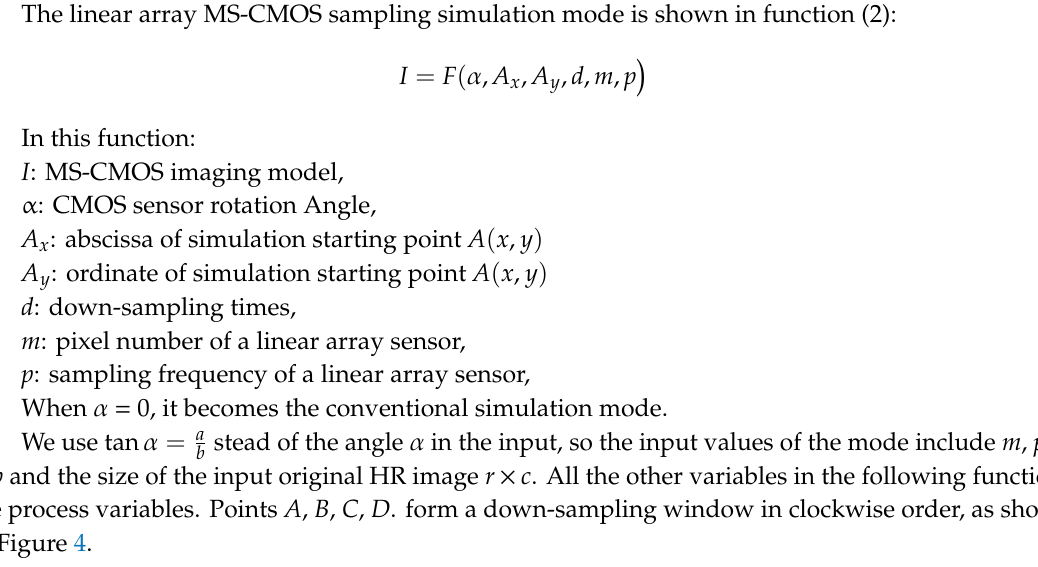
Figure 3. The flow chart of the imaging simulation mode.